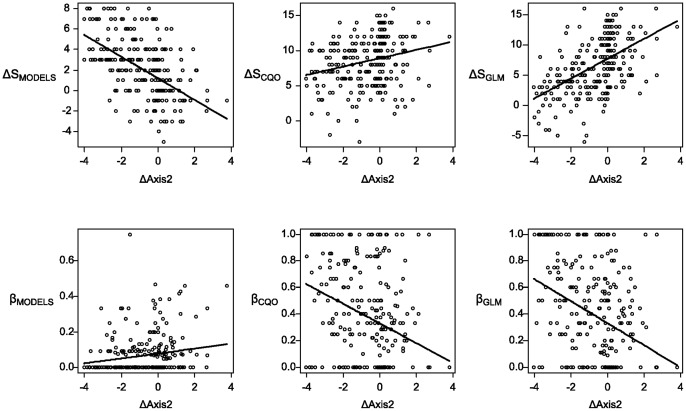
Differences in species richness and species composition projected by both approaches CQO and GLM under 2007 environmental conditions and differences in species richness and species composition projected by CQO, GLM and 2007 real observations (respectively ΔSMODELS, βMODELS and ΔSCQO, ΔSGLM, βCQO, βGLM).These differences were correlated with changes in environmental predictors between 1982 and 2007.